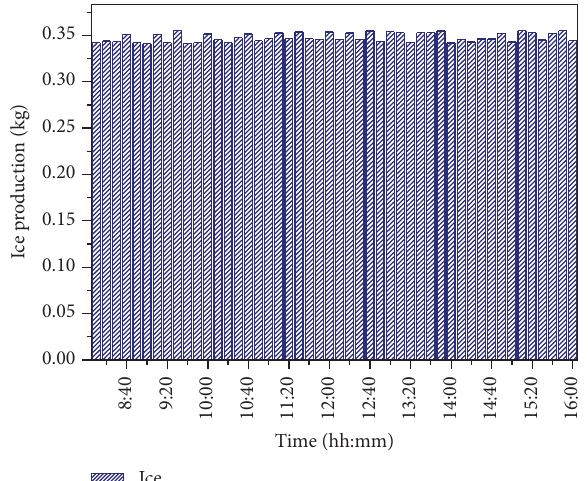
Figure 12: Ice production of ice maker driven by DPES from 8:00 to 16:00 on 22nd Nov., 2015, in